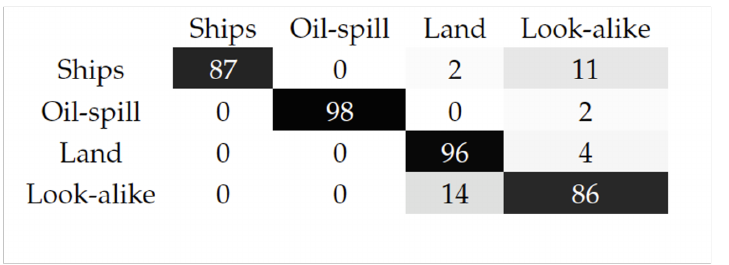
Figure 6. Average rounded confusion matrix (in terms of percentage) for SAR classification using InGaMM-eV for ESA-SAR dataset.